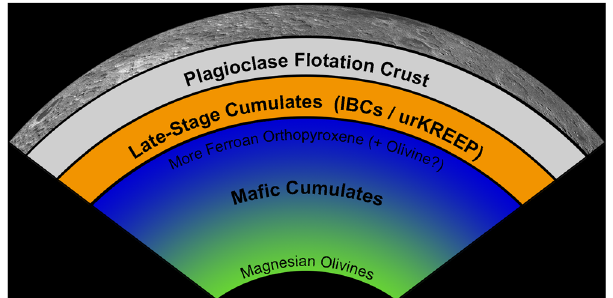
Fig. 1 A generalized schematic overview the Lunar Magma Ocean cumulate stratigraphy. Because gravitational restructuring of the lunar mantle is probably initiated prior to complete magma ocean solidi fi cation, the actual structure of the lunar interior is not expected to exhibit this precise form at any point in lunar history. For example, late stage cumulates (including ilmenite-bearing cumulates (IBCs) and cumulates highly enriched in incompatible elements (urKREEP)) are thought to sink prior to complete solidi fi cation of the underlying ma fi c cumulates. Layer thicknesses are not to